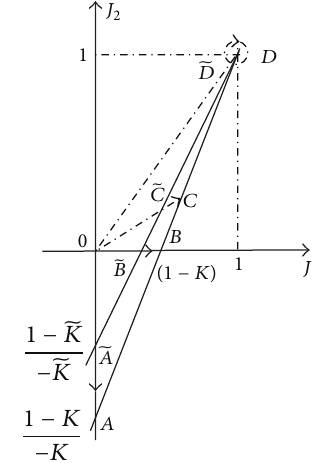
Figure 4: Comparison of loading regime of two different